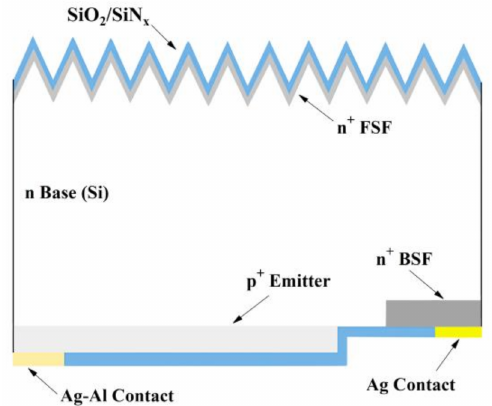
Figure 1. Schematic of the cross section of the studied industrially viable interdigitated back contact (IBC) solar